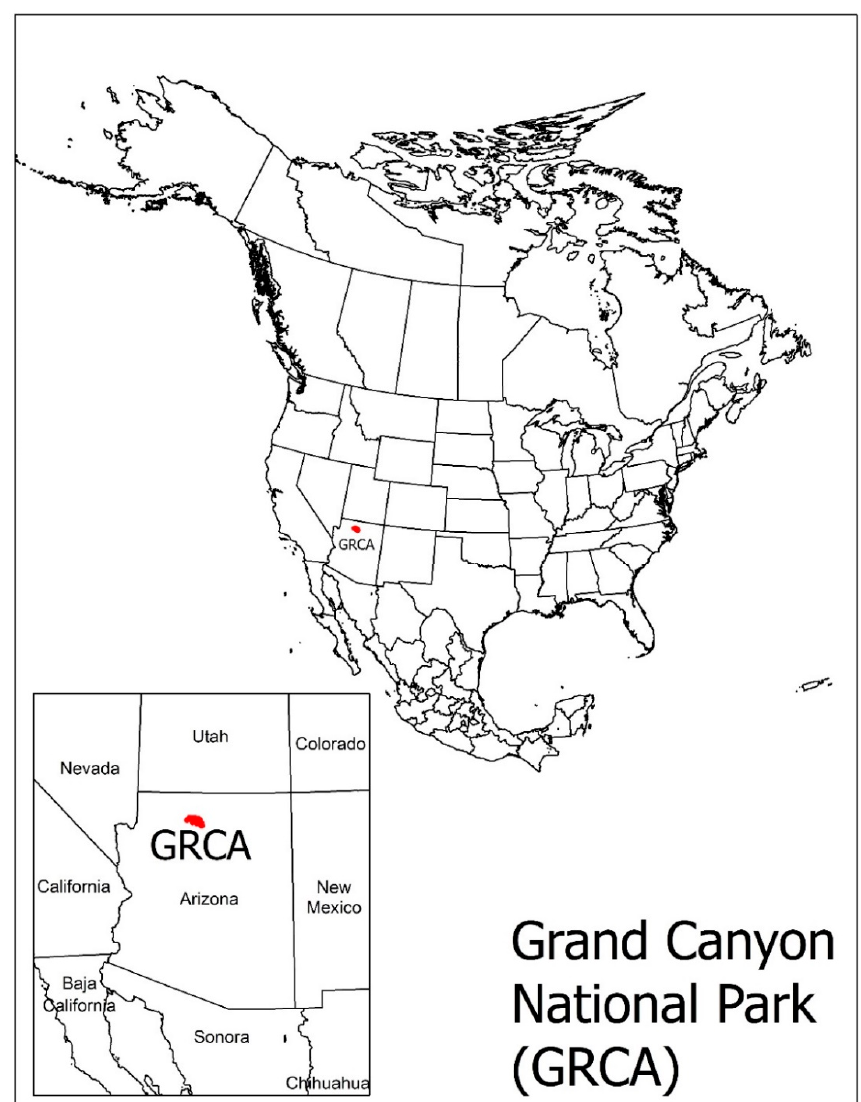
Figure A1. Location map for Grand Canyon National Park, Arizona, USA. The North Rim of the Grand Canyon, in Grand Canyon National Park, is located on the Kaibab Plateau in Northern Arizona.